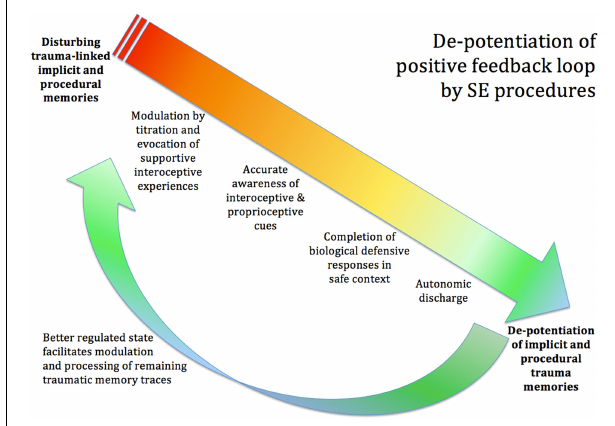
FIGURE 7 | De-potentiation of positive feedback loop by SE. The procedures of SE can de-potentiate the disturbing trauma-linked implicit and procedural memories. Titration and the co-evocation of supportive and empowering interoceptive experiences calm the extreme arousal and facilitate accurate awareness of the interoceptive and proprioceptive cues. The client becomes able to identify the urge toward completion of the biological defensive response; and, in the safe and supportive context created by the therapist, is able to complete the blocked defensive response, through imagery and subtle movement. This will often be accompanied by autonomic discharge in the form of heat, trembling, tears, and so on. Once the proprioceptive experience of biological completion has occurred, the memories lose their intense charge, and may now integrate into the hippocampal autobiographical timeline like ordinary memories. Now that the client’s nervous system is in a more functional state, the client has more resilience and a greater capacity to tackle any remaining trauma-related